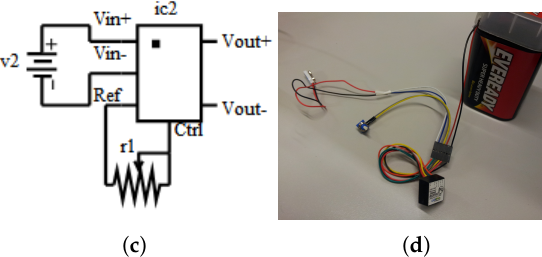
Figure 3. Schematic and assembly of constant current sources: ( a ) input terminals (V in+ , V in − ) of the